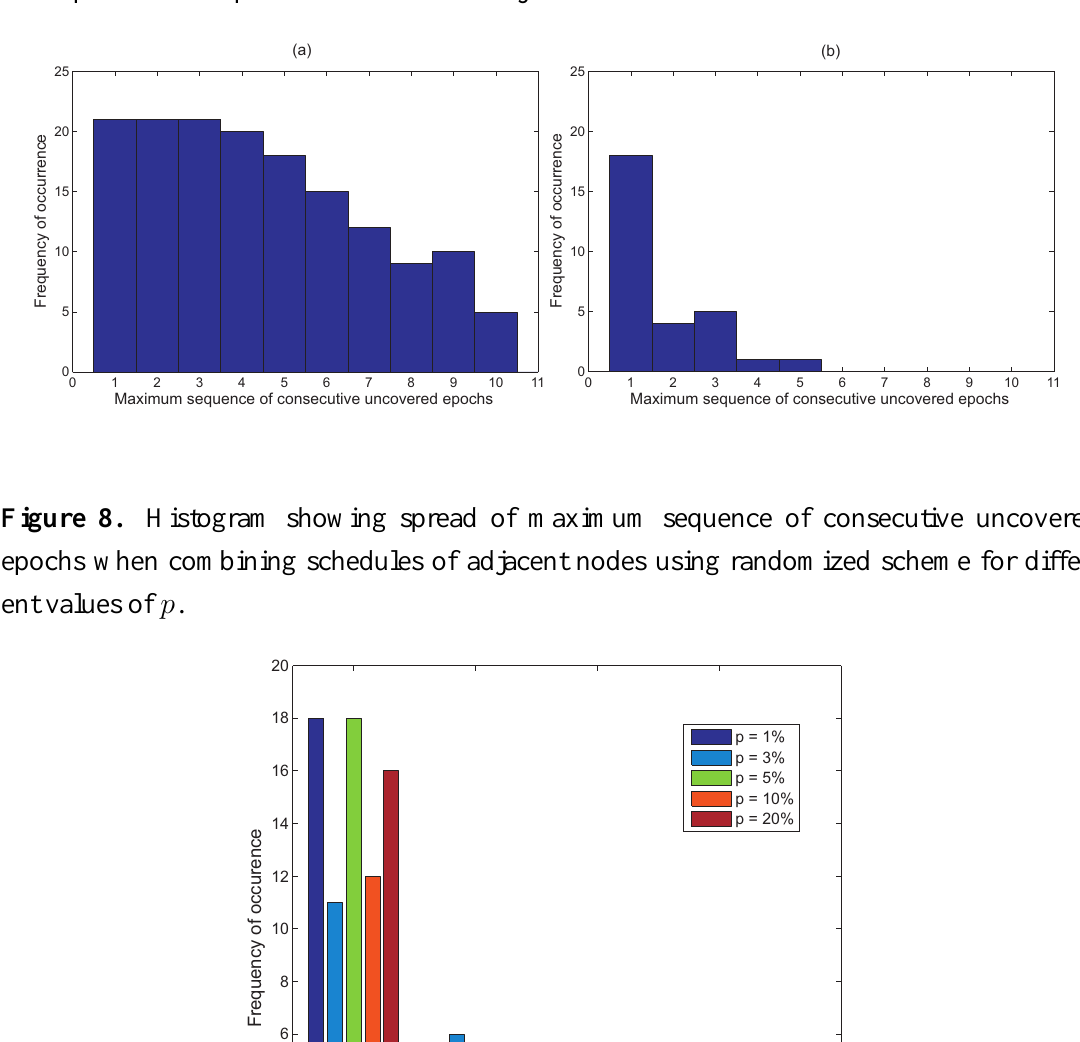
Figure 7. (a) Histogram showing spread of maximum sequence of consecutive uncovered epochs for AS algorithm; (b) Histogram showing maximum sequence of consecutive uncov- ered epochs when spatial correlations of adjacent nodes is considered.